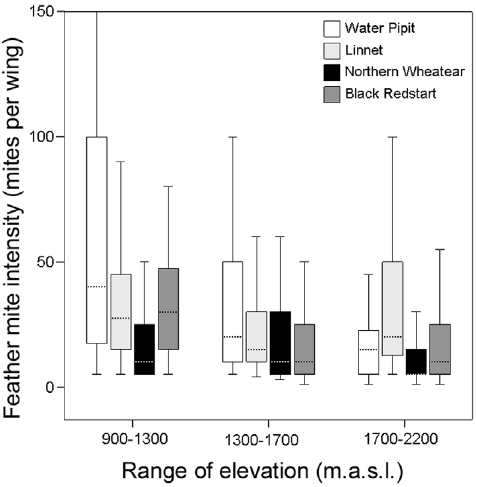
Figure 3. Feather mite intensity along elevation. Box-plot of feather mite intensity along the elevation gradient. Only the four best sampled species are shown.